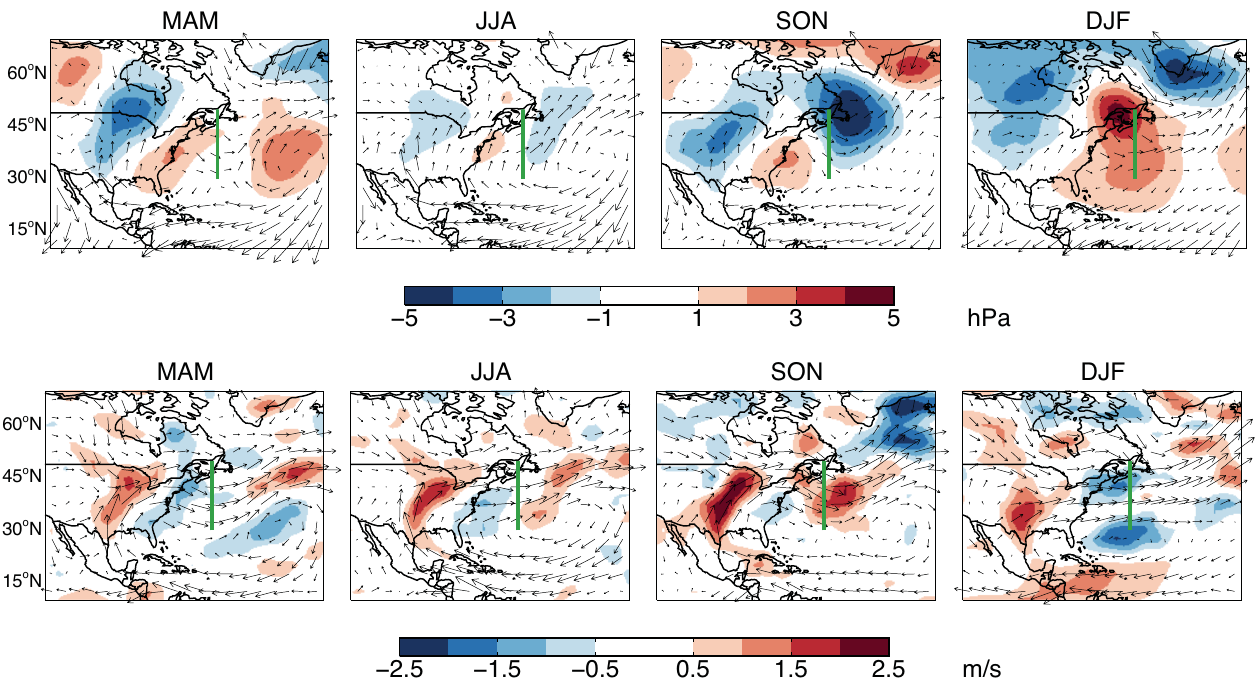
Fig. 9. Seasonal composites of meteorological field anomalies 2 days before N. American LRT + events for 2004-2010. Top: sea level pressure anomalies (filled contours) and surface wind fields (arrows). Bottom: 850hPa wind speed anomalies (filled contours) and wind fields